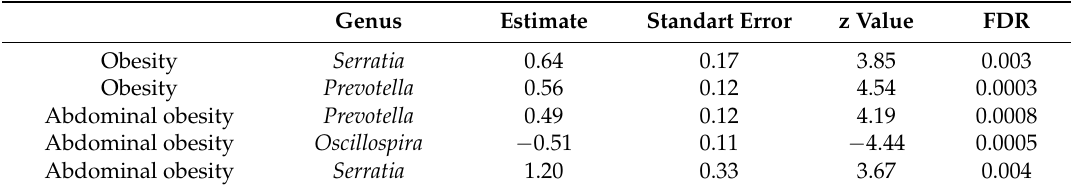
Table 2. Links of gut microbial genera levels with body mass index (BMI) and abdominal obesity according to generalized linear models modeling results. Genus Estimate Standart Error z